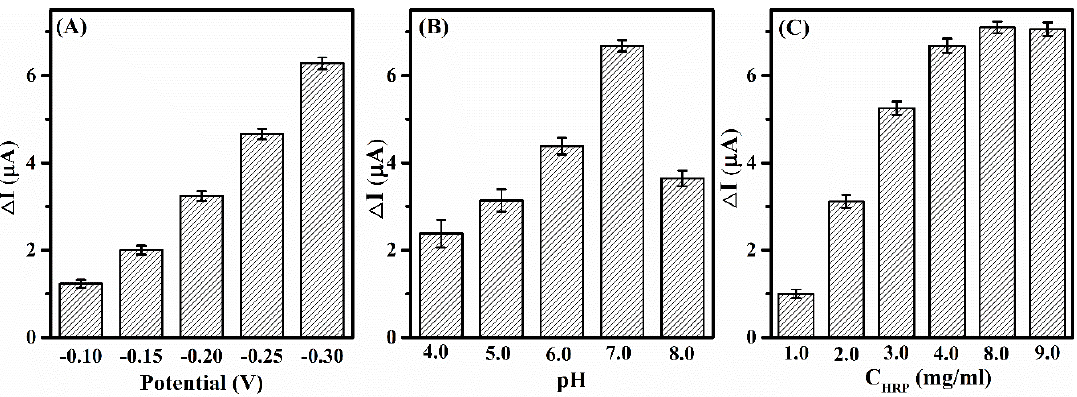
Figure 9. Optimization for operating potential ( A ), pH ( B ) and amount of HRP immobilized on electrode ( C ).